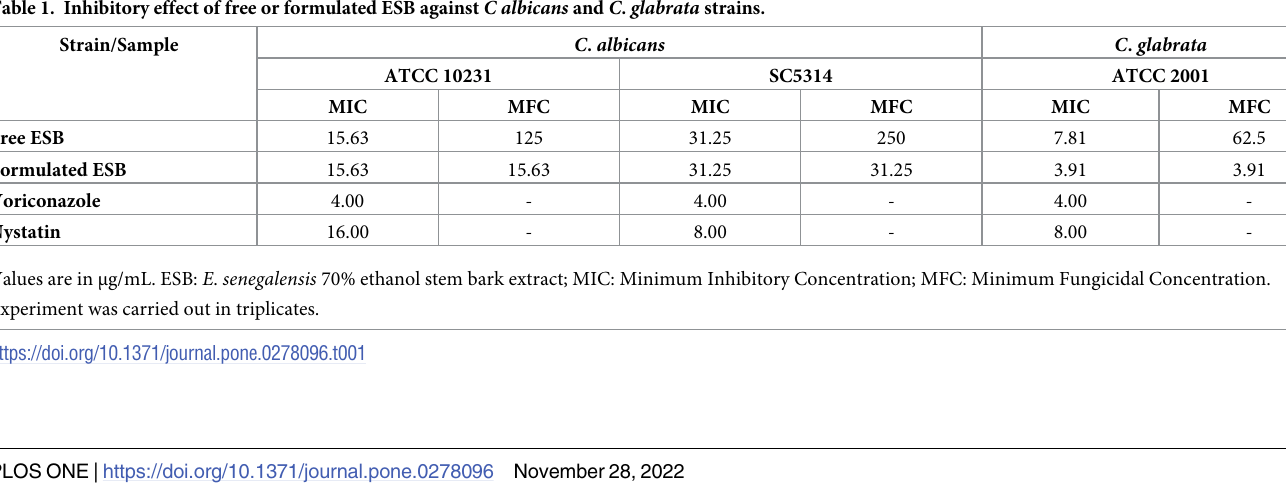
Table 1. Inhibitory effect of free or formulated ESB against C albicans and C . glabrata strains. Strain/Sample